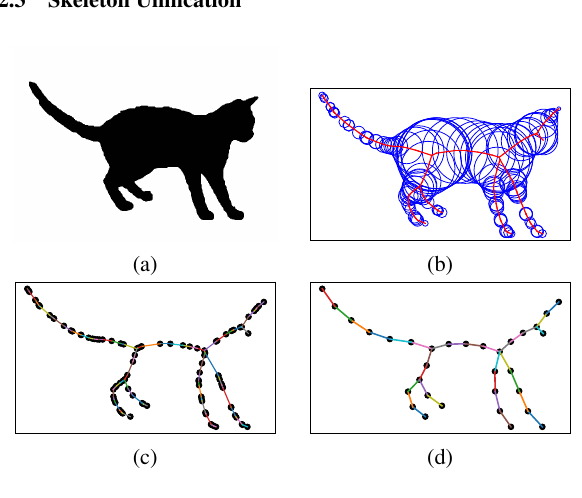
Figure 1. Fixed length skeleton